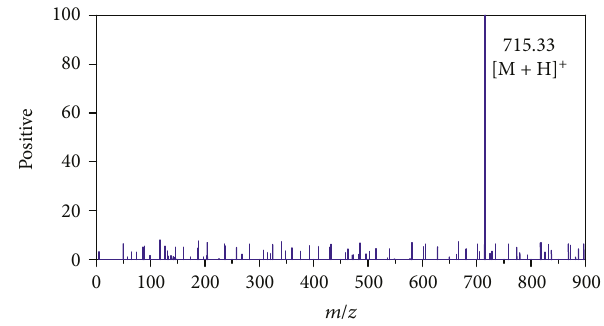
Figure 4: Cumulative release curve. PSO cumulatively released from HA/PSO/C NPs was quanti fi ed using HPLC until 48h. Data are shown as means ± SD ( n = 3